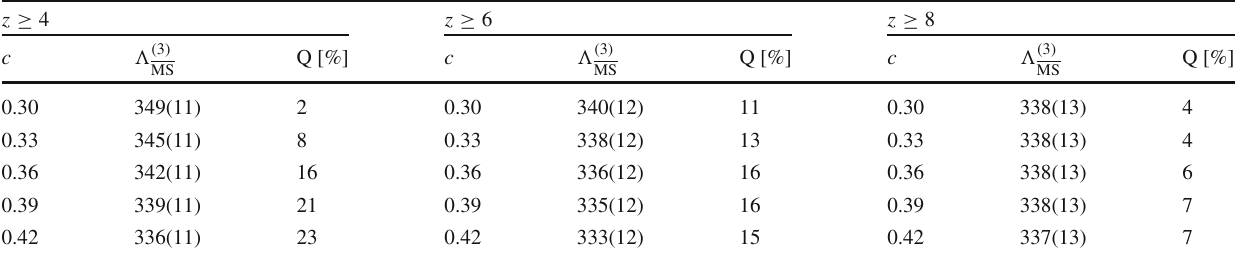
Table 4 Estimates of (cid:3) ( 3 ) (see Table 3) are extrapolated to M → ∞ according to Eq. (4.13) with ˆ (cid:15) m = 0. We also quote the Q − value of MS , eff